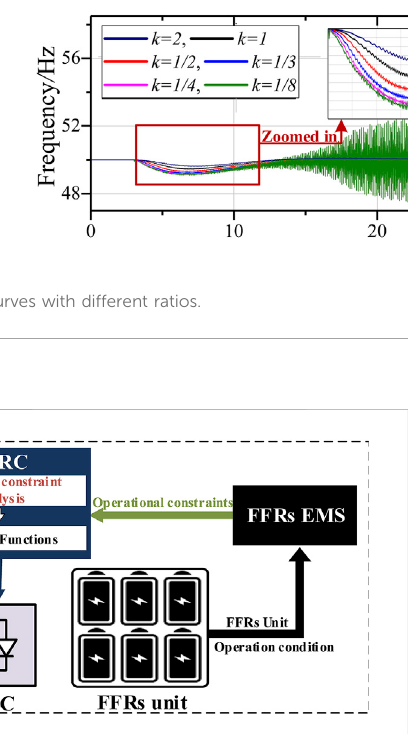
FIGURE 6 Basic control diagram of the